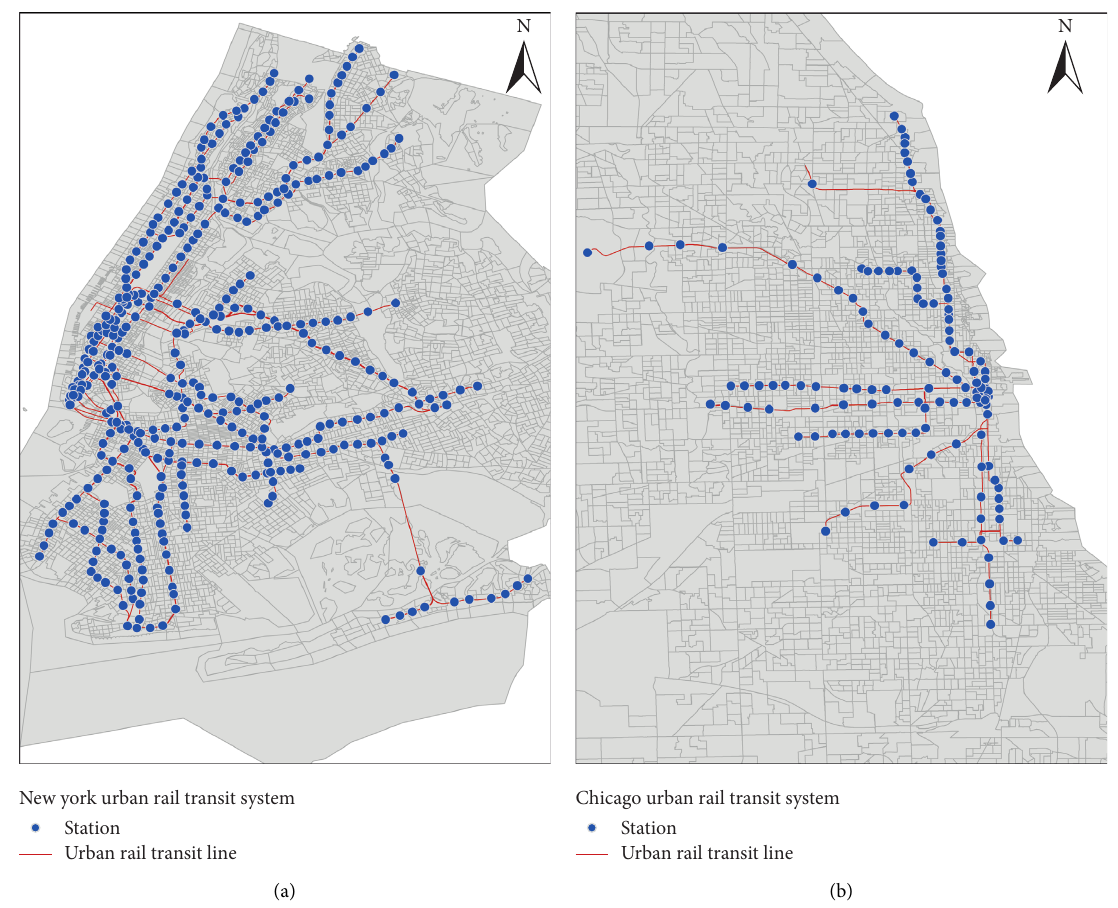
Figure 1: The urban rail transit systems of New York and